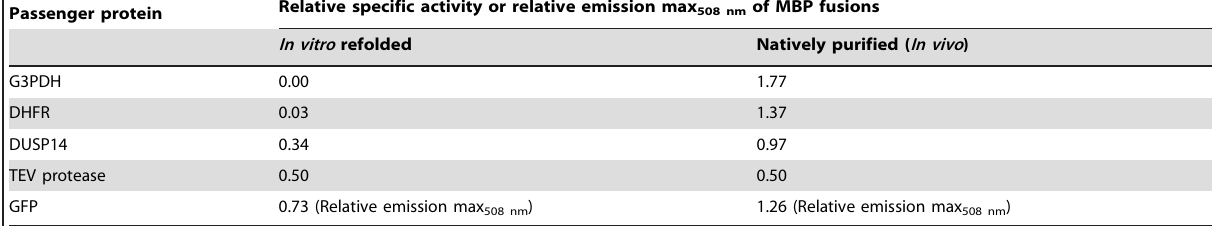
Passenger protein